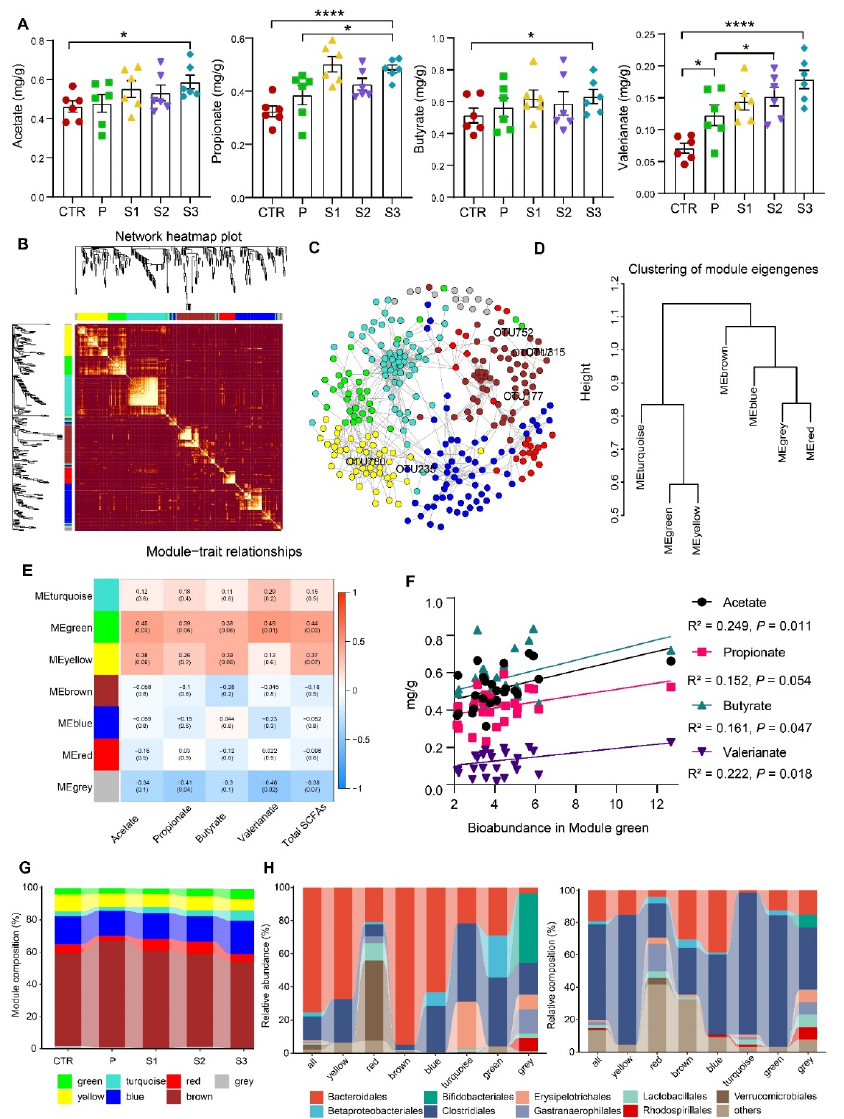
Figure 4. The relationship between the production of SCFAs and OTU clusters. ( A ) SCFA contents in cecum; ( B ) heatmap of topological overlap in the OTU network, where each row and column corresponds to an OTU. The dark red color represents low topological overlap, while the lighter orange color represents higher topological overlap; ( C ) network diagram with nodes colored according to each of the seven microbial clusters; ( D ) hierarchical clustering dendrogram of module eigen-OTUs; ( E ) correlation among modules and traits; ( F ) the regressed relationships between the keystone microbial cluster (green) and production of SCFAs; ( G ) module changes among groups; ( H ) OTU abundance (left panel) and OTU composition (right panel) in each module ( n = 6). * p < 0.05, **** p < 0.0001.